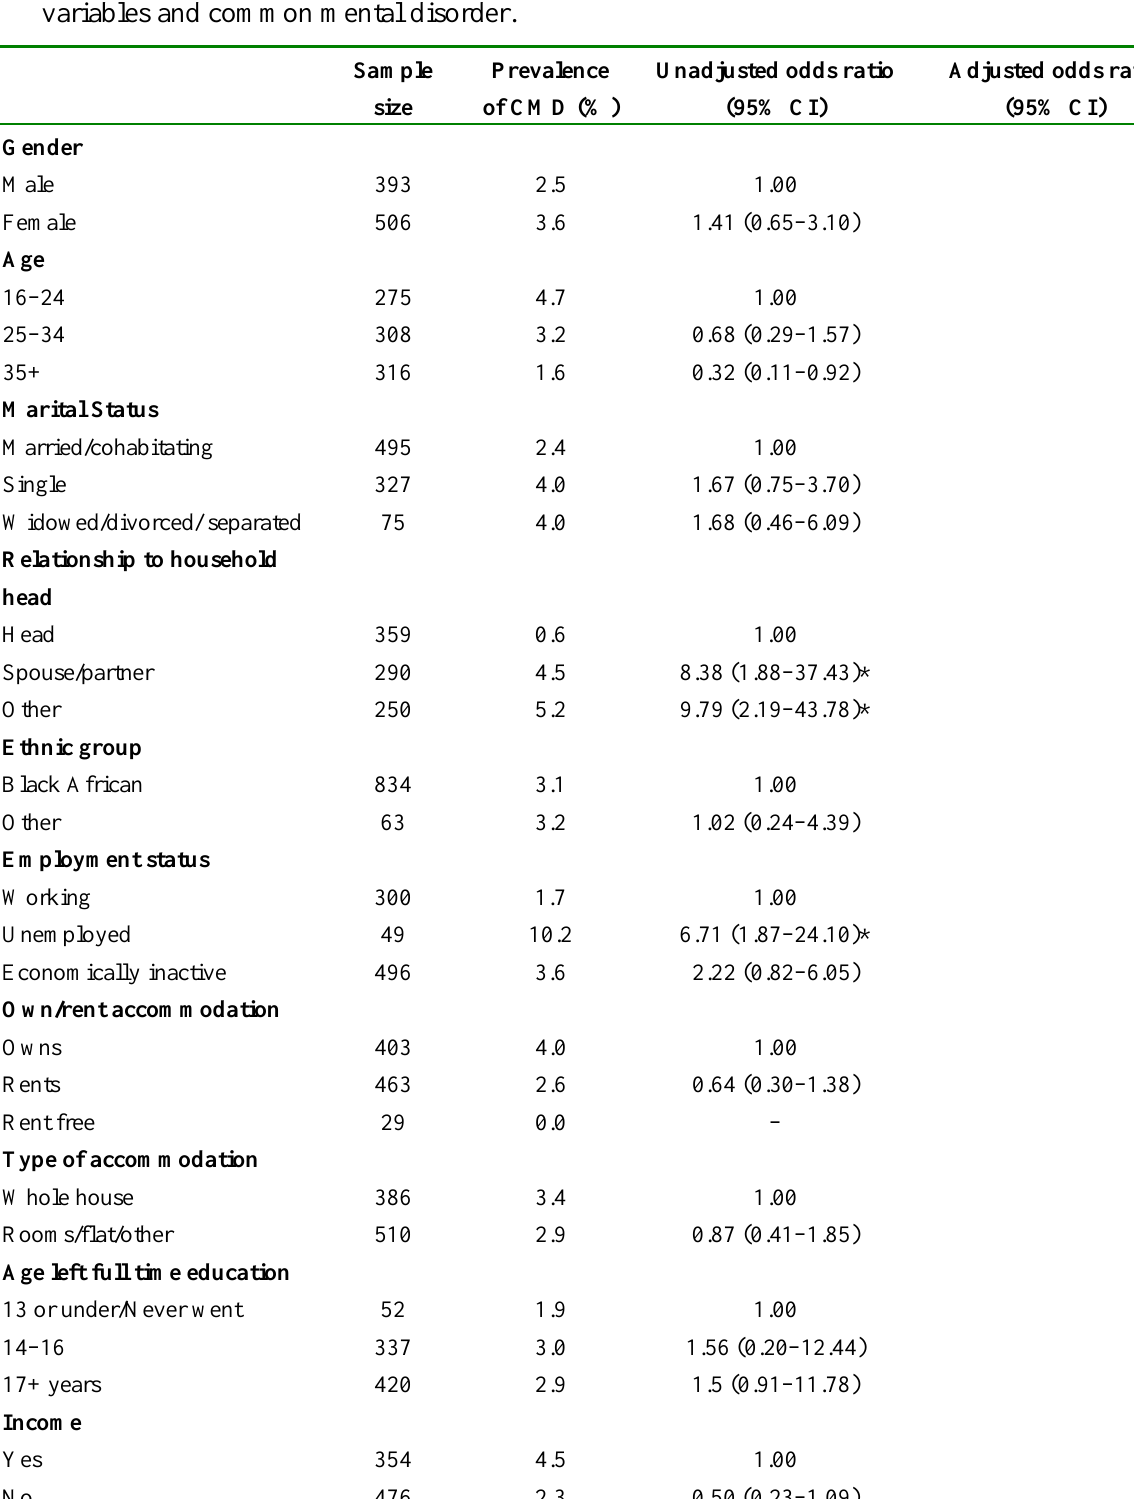
Table 3. Unadjusted and adjusted odds ratios for demographic and socio-economic variables and common mental